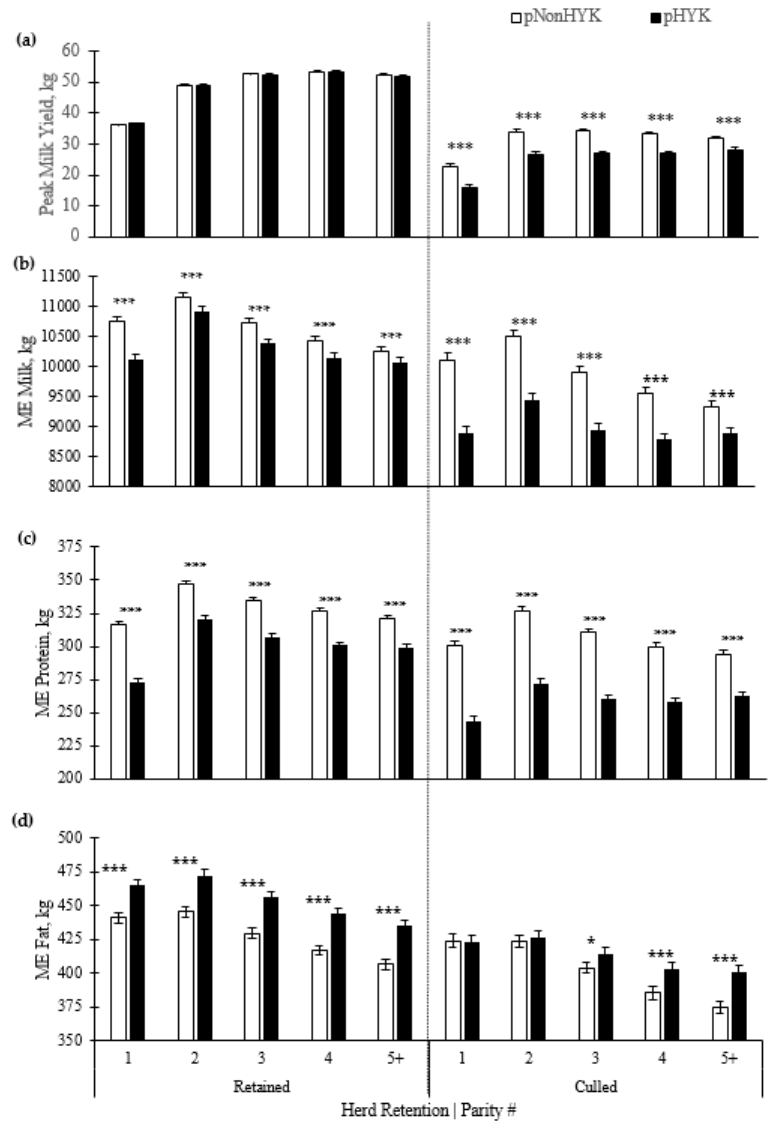
Figure 6. Parity by predicted hyperketonemia (HYK) status interaction within retained or culled (first 60 d) cows on ( a ) peak milk yield (kg); ( b ) mature equivalent (ME) milk (kg); ( c ) ME protein (kg); and ( d ) ME fat (kg). Blood ß-hydroxybutyrate (BHB) was predicted based on test day milk sample and production variables collected between 5 to 20 days in milk. Predictions were classified as predicted HYK (pHYK; predicted BHB ≥ 1.2 mM) or not (pNonHYK; predicted BHB < 1.2 mM) for analysis of records. Records per lactation: 1, 88,782; 2, 67,327; 3, 43,790; 4, 23,999; 5+, 16,816. Parity × predicted HYK × retention interactions p ≤ 0.002. Symbols indicate simple effect of classification (***, p < 0.001; *, 0.01 < p < 0.05) within parity.